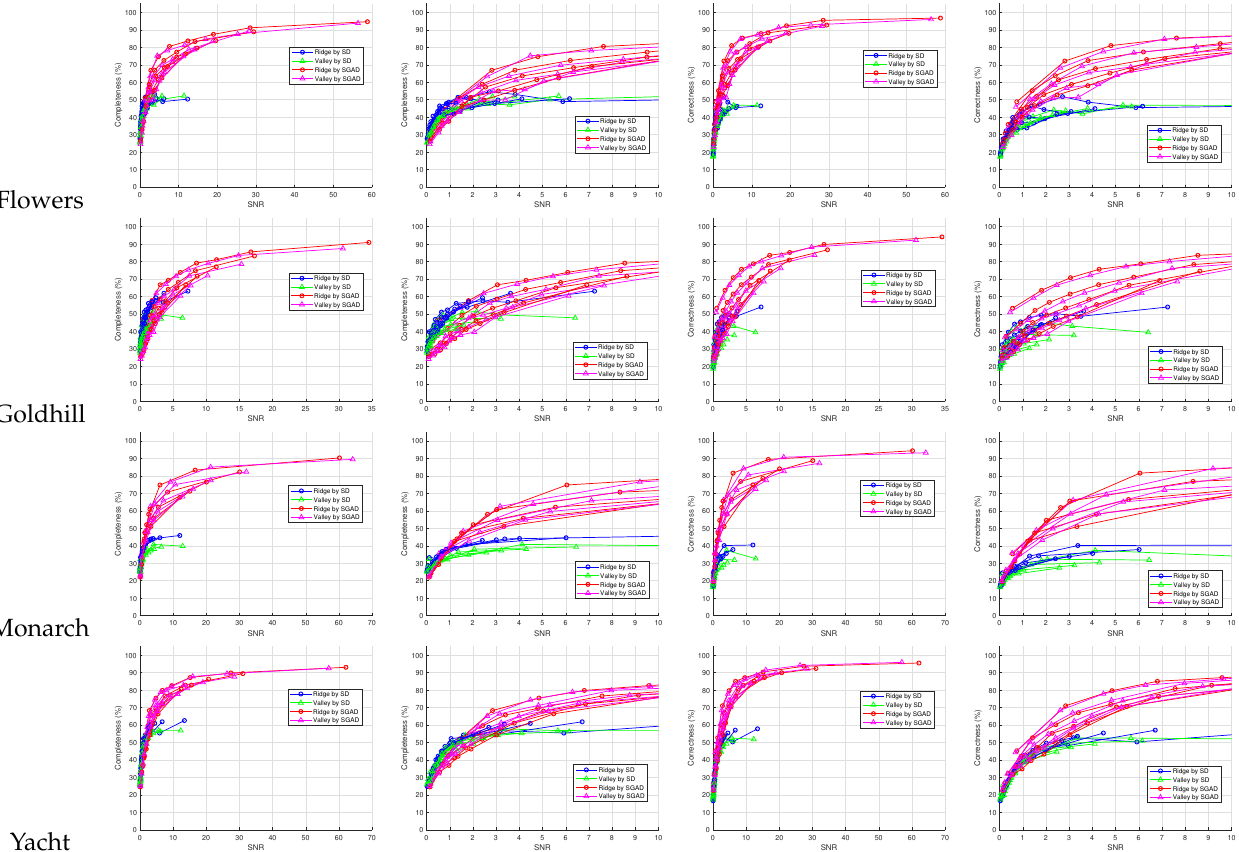
Figure 15. Completeness and correctness against SNR for the natural images. The second and fourth columns show the zoom-in versions of the plots in the first and third columns with SNR range [0, 10],